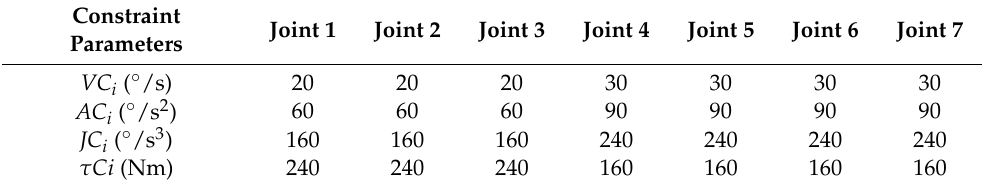
Table 3. Necessary kinematic and dynamic constraints of joints.